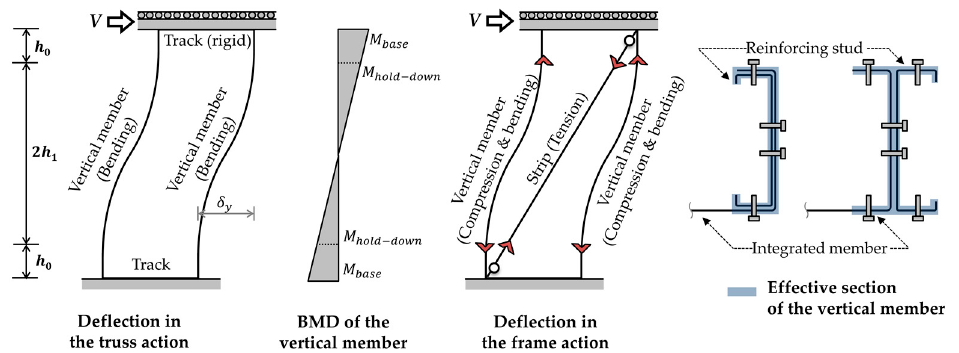
Figure 14. Force mechanism acting within the integrated panel with reinforced studs.